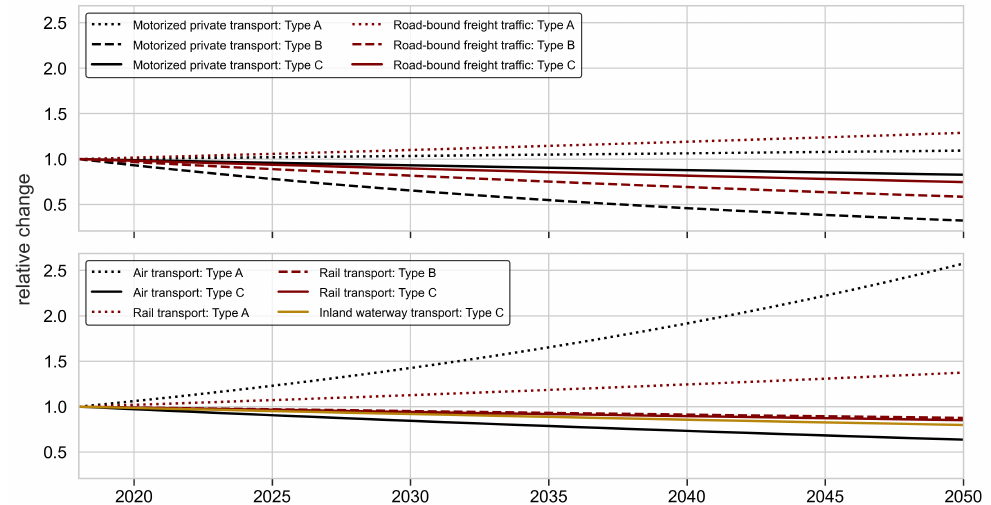
Figure 7. Example of change in final energy consumption due to transport performance increase and efficiency increase in the individual transport types by 2050 relative to 2018. The upper part shows the modeled final energy change of private motorized transport and road-based freight transport, and the lower part of the figure shows air transport, rail transport, and inland waterway transport. By varying the values of the measure described in Section 3.3, any scenario in the transport sector can be